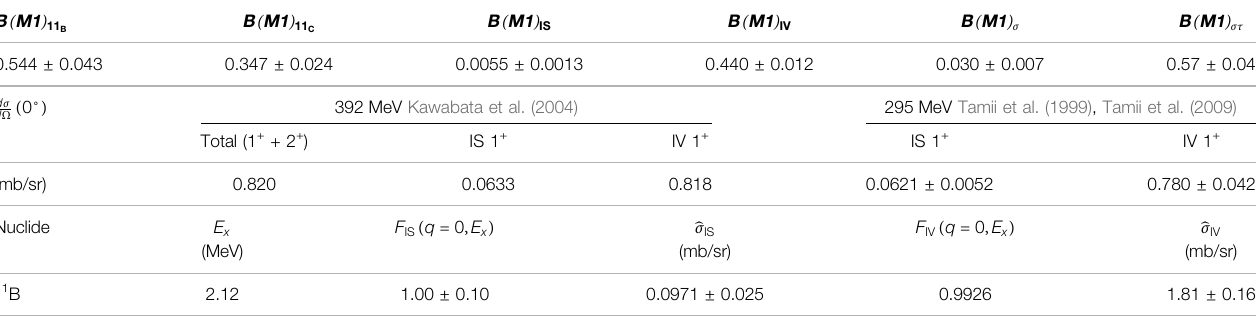
TABLE 2 | Data used for obtaining UCSs of 11 B. The upper table is expressed in unit of μ 2 N .